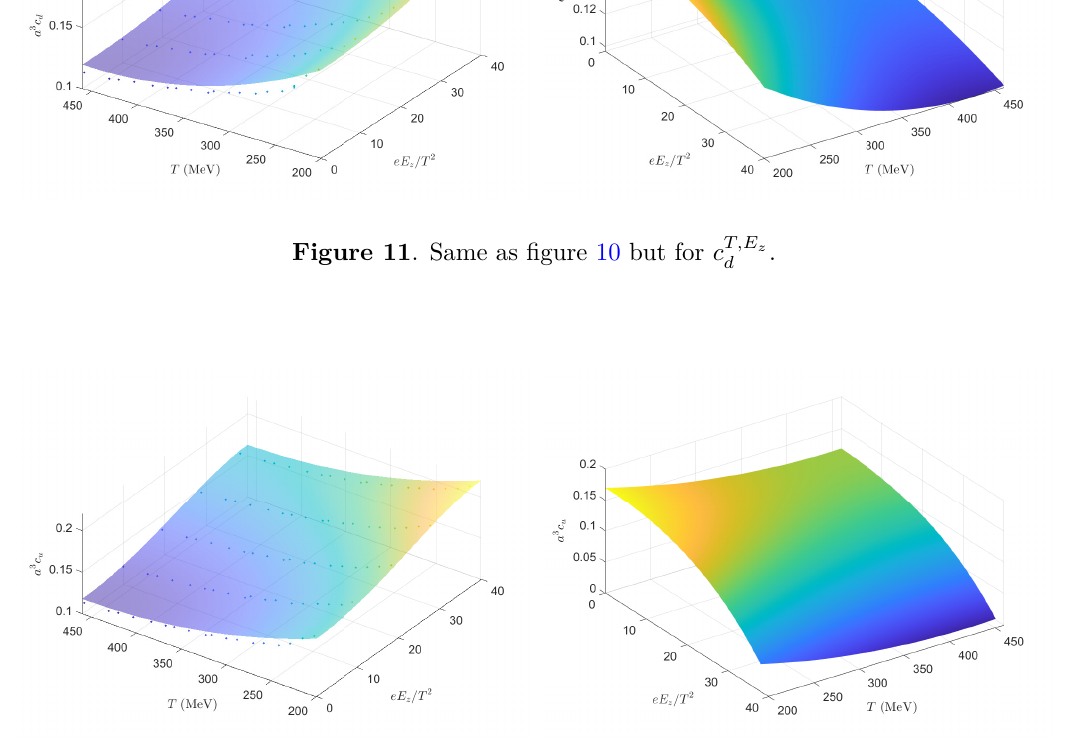
Figure 12 . Same as figure 10 but fitted using eq. (3.7).